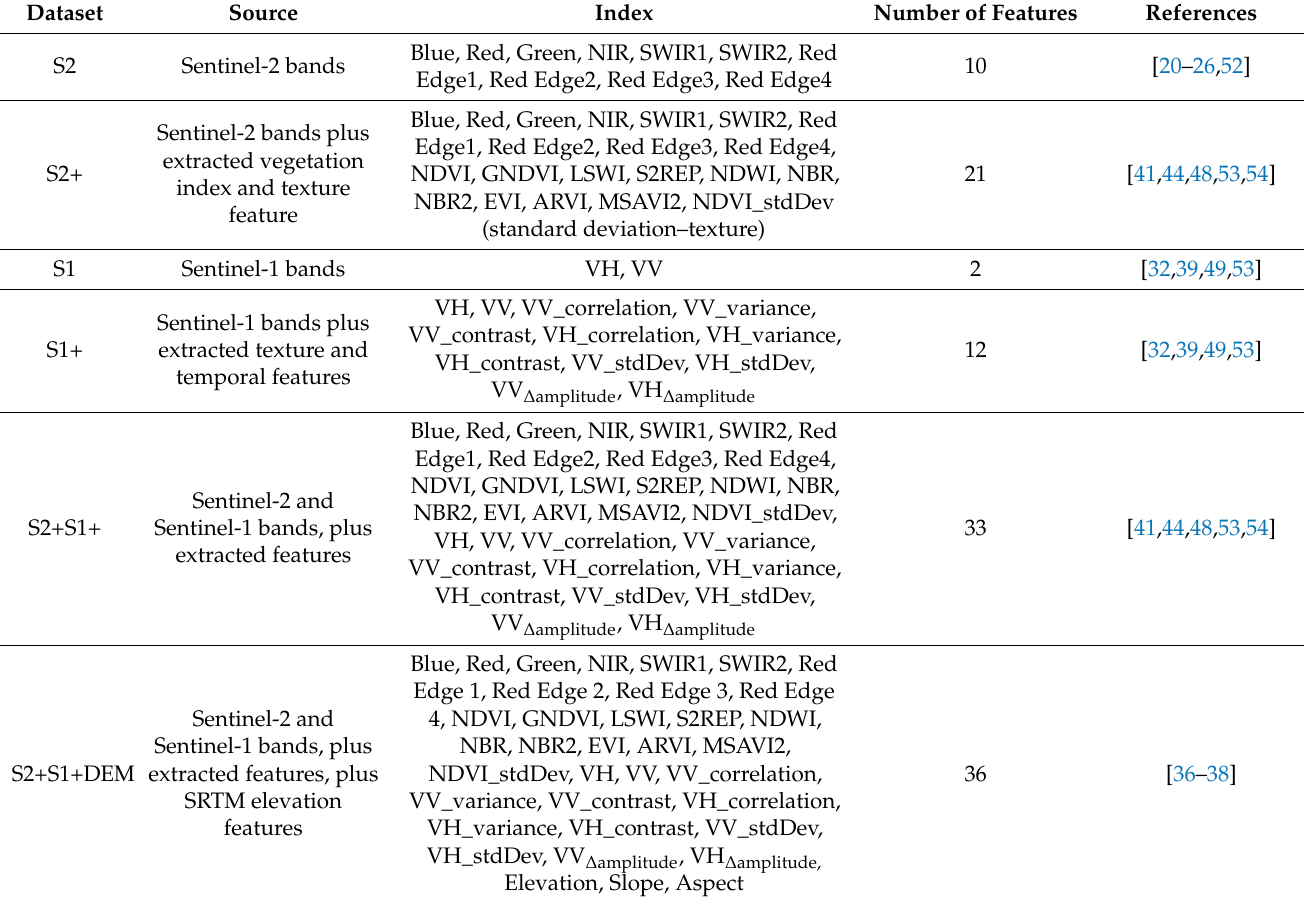
Table 3. Features considered for land cover